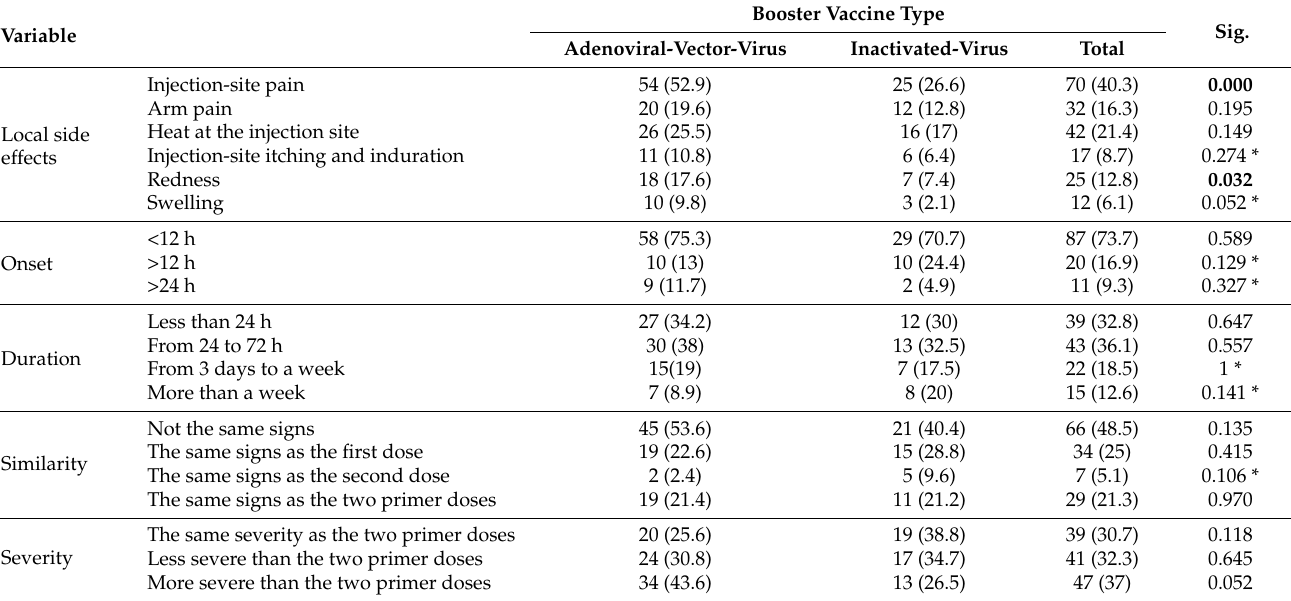
Table 3. Frequency and characteristics of local side effects of the Algerian